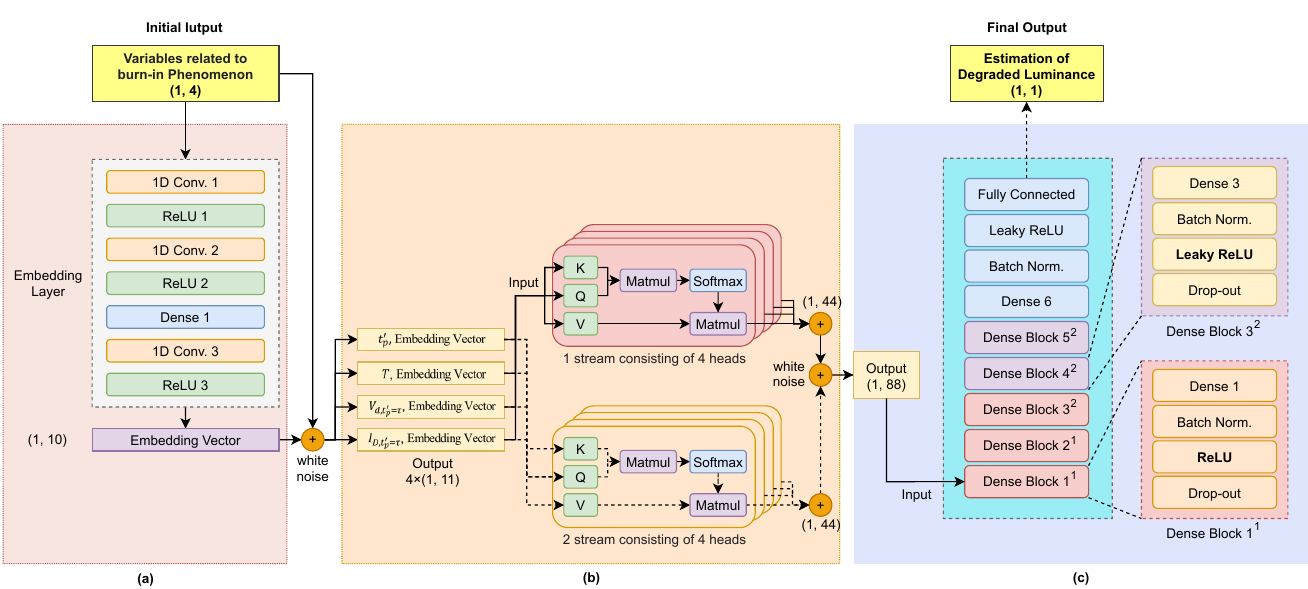
Figure 3. Overview of entire model: ( a ) deep feature generation; ( b ) multistream self-attention; ( c ) deep neural